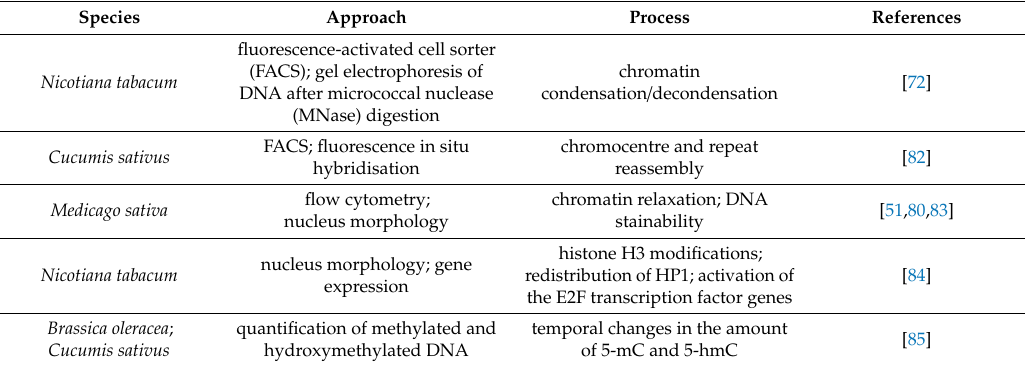
Table 2. Studies on the epigenetic status of mesophyll protoplasts during in vitro culture. Species